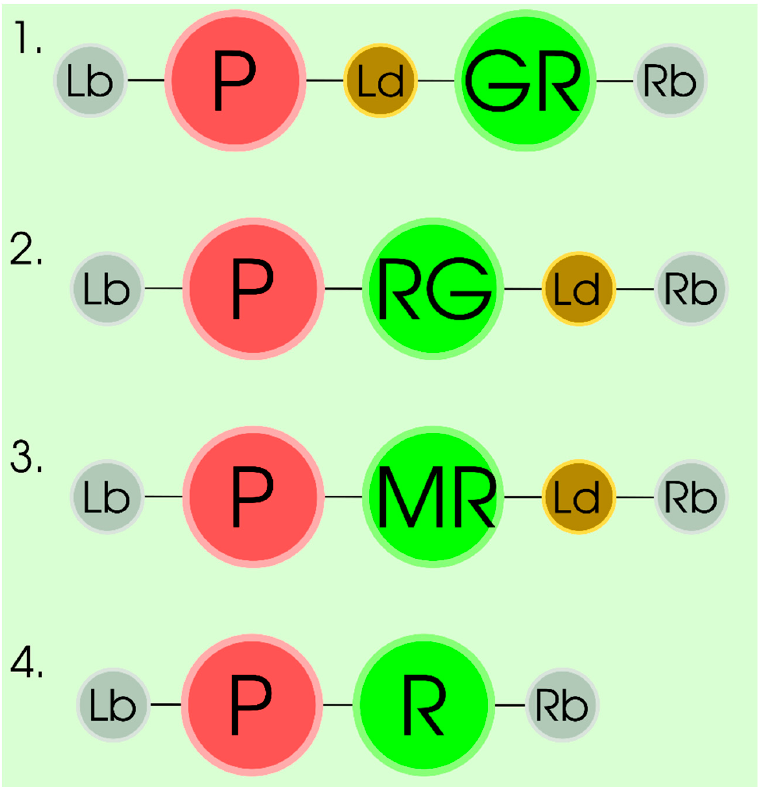
Figure 2. Scheme of T-DNA gene constructs for studying the localization of gene products in a plant cell. 1 and 2—constructs for studying the localization of gene products in a plant cell depending on the localization of the signal peptide of the target gene in the N- or C-terminal region of the target protein, respectively. GR or RG—hybrid gene where the target gene (G) is transcriptionally and translationally fused with the gene coding for reporter protein (R) under the control of a strong constitutive promoter (P), Sp—signal peptide for target protein. 3—positive control, a gene construct carrying the specific markers for plant cell compartments under the control of the same promoter; 4—negative control, a gene construct carrying only the gene coding for a reporter protein under the control of the same promoter; P—a strong constitutive promoter; Lb, R—T-DNA left and right borders.